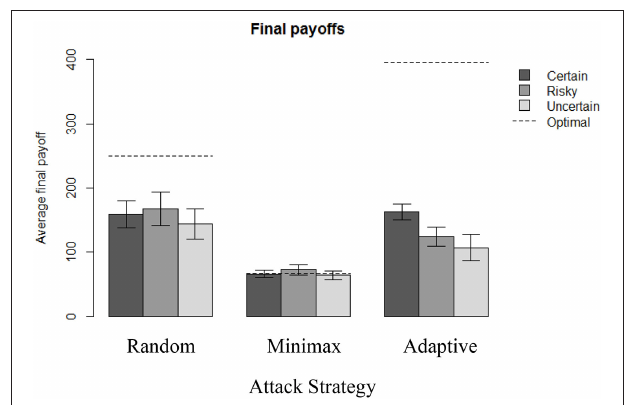
FIGURE 3 | Final payoffs in each condition across 100 rounds. Initial endowment = 200 pts. The dotted lines represent the corresponding final payoff when the optimal solution is applied